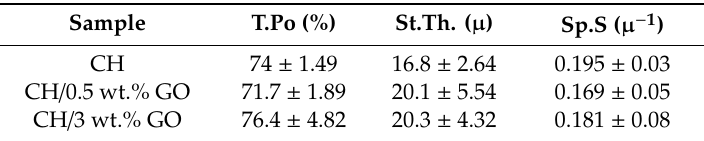
Table 1. Spreadsheet of the readings of total porosity (T.Po), structure thickness (St.Th), and specific surface (Sp.S), calculated as the ratio of object surface and object volume. The numbers are the average values of the 3D analysis carried out in CTAn for six distinct proportionate volumes of interest (VOIs) per composite